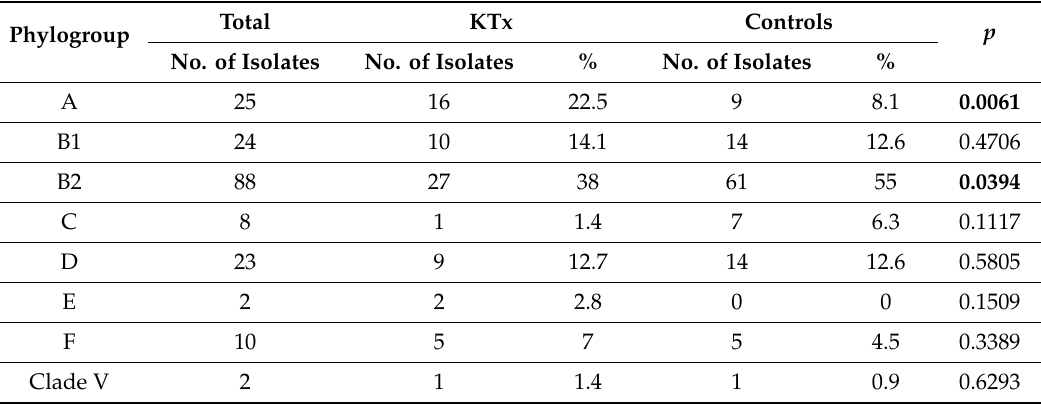
Table 2. Distribution of phylogroups in relation to KTx and control UPEC